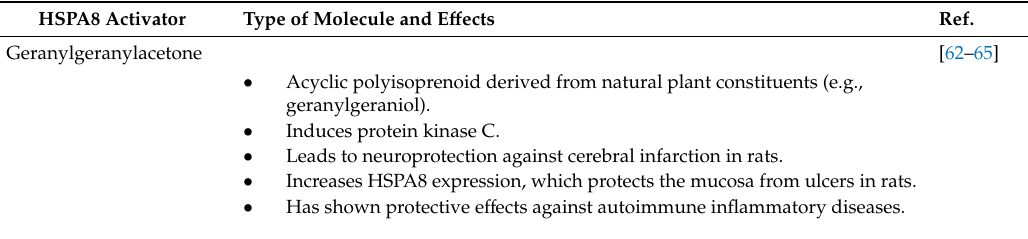
Table 2. HSPA8 activators.